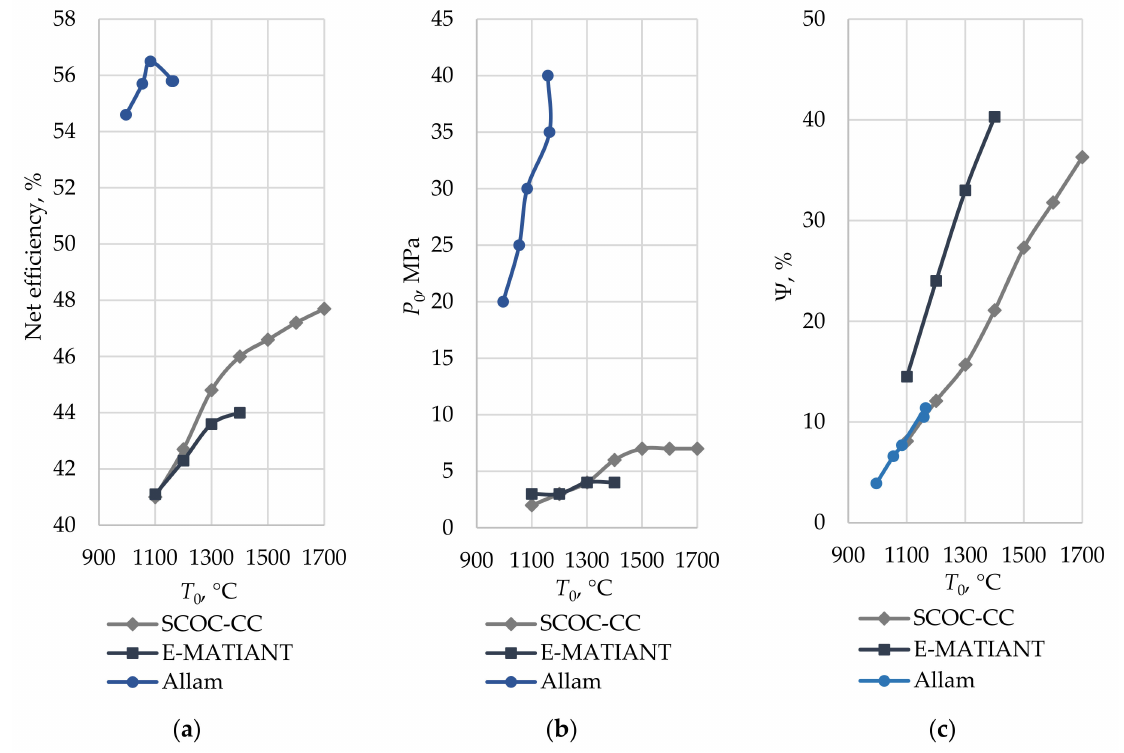
Figure 15. Results of oxy-fuel combustion power cycles’ parametric optimization: ( a ) net efficiency vs. initial parameters; ( b ) optimal initial pressure vs. initial temperature; ( c ) Ψ coefficient vs. initial